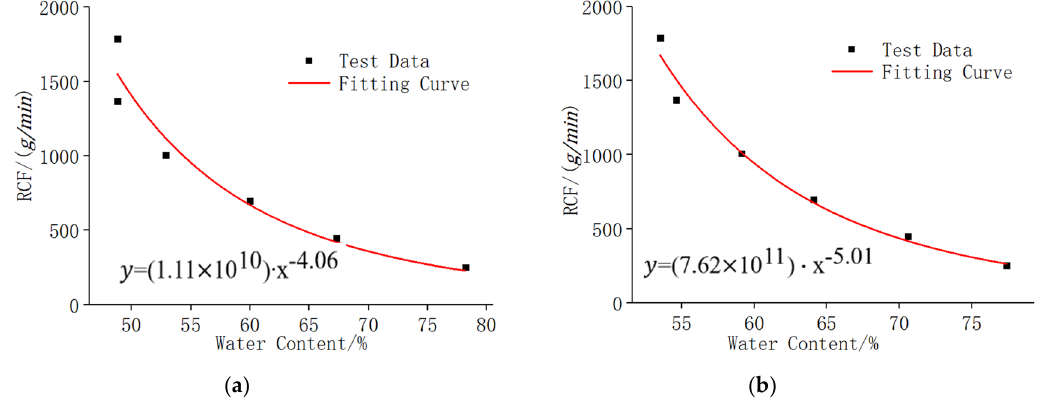
Figure 9. The relationship between the T2 cutoff and the water retention of the samples at a cement–tailings ratio of 1:8. ( a ) concentration of 71%; ( b ) concentration of 74%